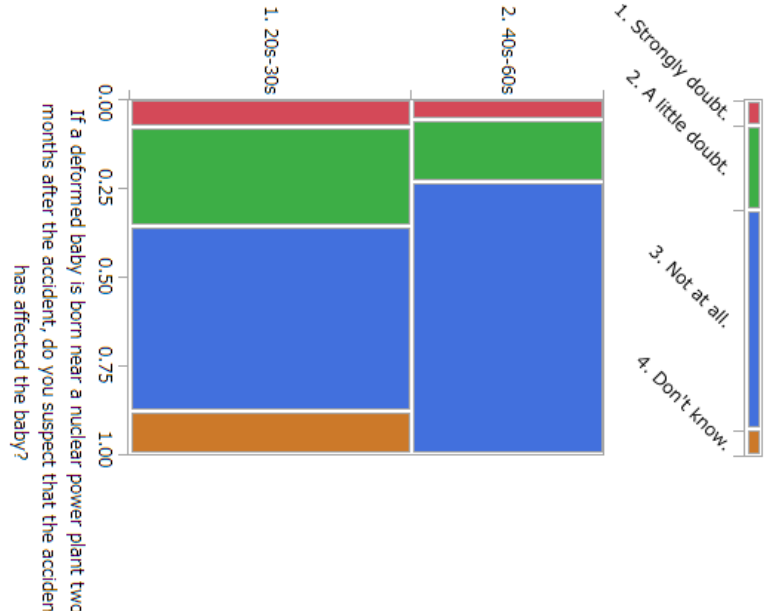
Figure 18. Responses to item No. 26 by Age Group.